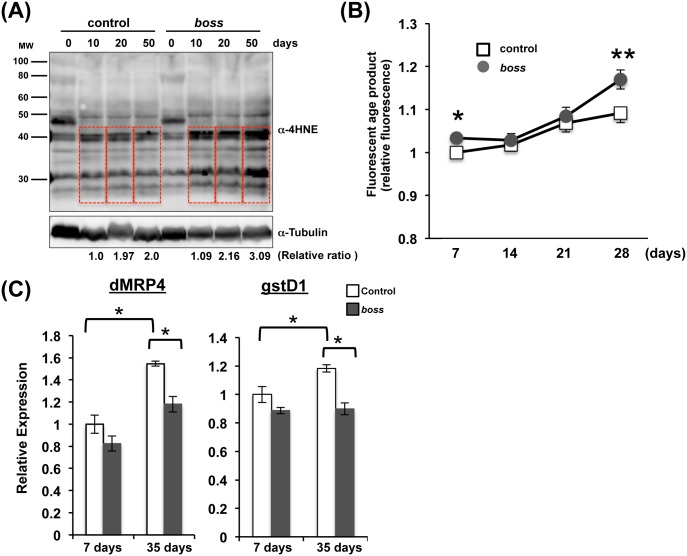
Oxidative stress is enhanced in boss mutant flies.(A) ALEs were detected by Western blot and antibodies against 4-hydroxy-2-nonenal (4HNE). Ages (0~50-days old) are shown at the top of the blot. (B) Accumulation of fluorescent AGEs was measured in control and boss mutant flies (n = 3, 20 flies per replicate). Data are mean relative fluorescence ± SEM, and differences are significant by t-test (*P<0.05, **P<0.01). (C) Expression of ROS-inducible genes (dMRP4 and gstD1) in young (7-days) and old (35- days) flies, assessed by qRT-PCR (n = 3, 10 flies per replicate). Data are mean relative expression ± SEM, and differences are significant by t-test (*P<0.05).